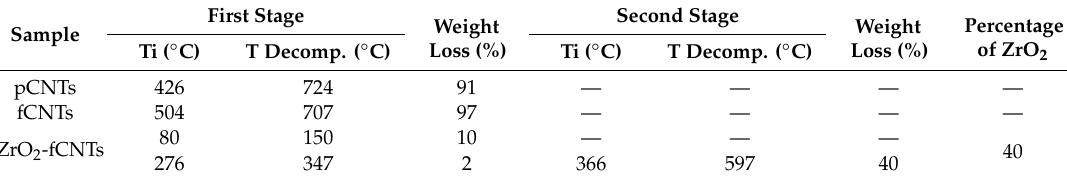
Table 2. Thermal analysis of pCNTs, fCNTs and ZrO 2 -fCNTs.